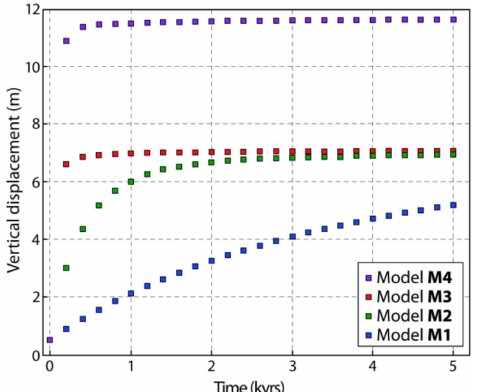
Figure 3. Time variation of the vertical displacement subsequent to the instantaneous disappearance of Megalake Chad as modeled in the area of the North-Bod é l é / Angamma deltaic complex and according to the four Earth models (M1–M4). In this coastal area showing the greatest hydro-isostatic rebound amongst the four studied areas, readjustment is quite rapidly fully achieved considering models M2, M3, and M4, but would be currently still active if model M1 was accounted